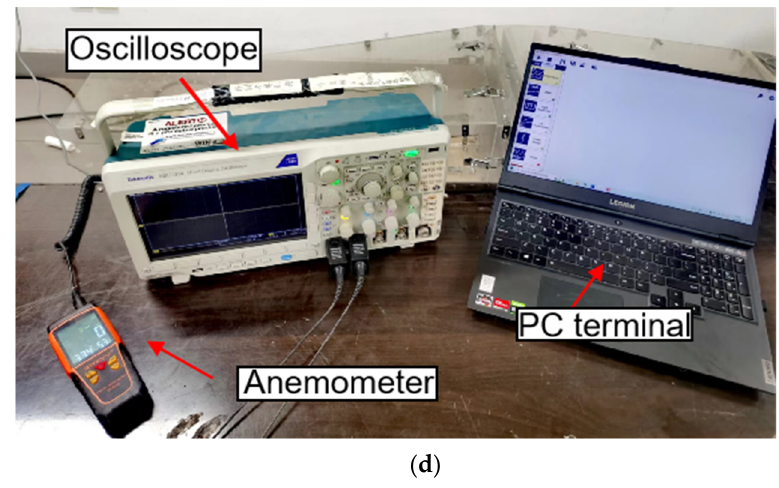
Figure 2. Experimental equipment: ( a ) wind tunnel device; ( b ) energy collection system; ( c ) experimental models of the EEH and the PEH; ( d ) data acquisition and processing system. Table 1. Structural and material parameters of the MPEGEH.